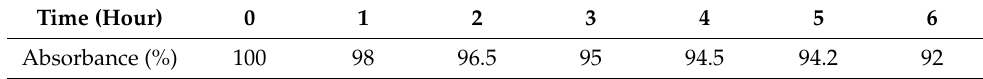
Table 1. The kinetic stability of the CSH